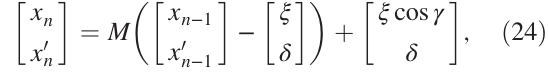
FIG. 5. A diagram of the simulation work flow. (OE stands for optical